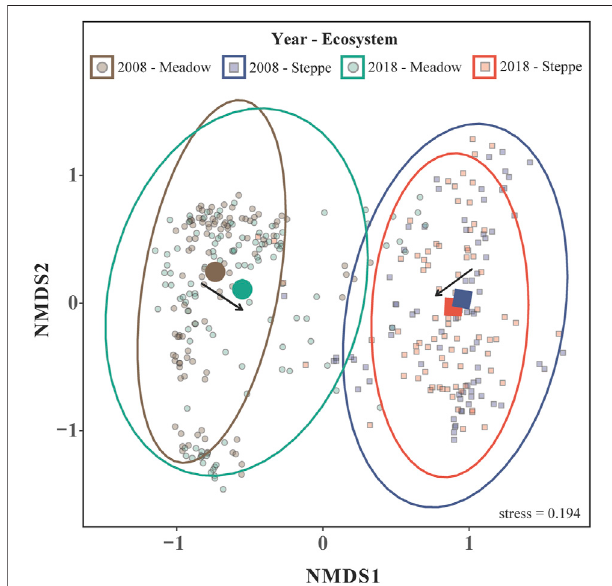
FIGURE 6 | Nonmetric dimensional scaling (NMDS) analysis showing differences in plant species composition between 2008 and 2018 for alpine meadow and steppe communities in the permafrost region of the Tibetan Plateau along the fi rst and second NMDS axes.